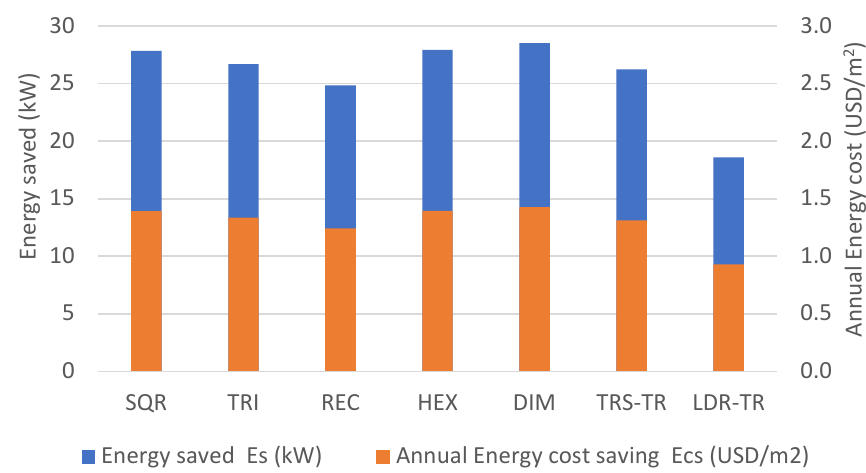
Figure 9. Energy saved and associated electricity cost reduction ($0.05/kWh) using different 3DPC infill structures versus a red clay brick wall.